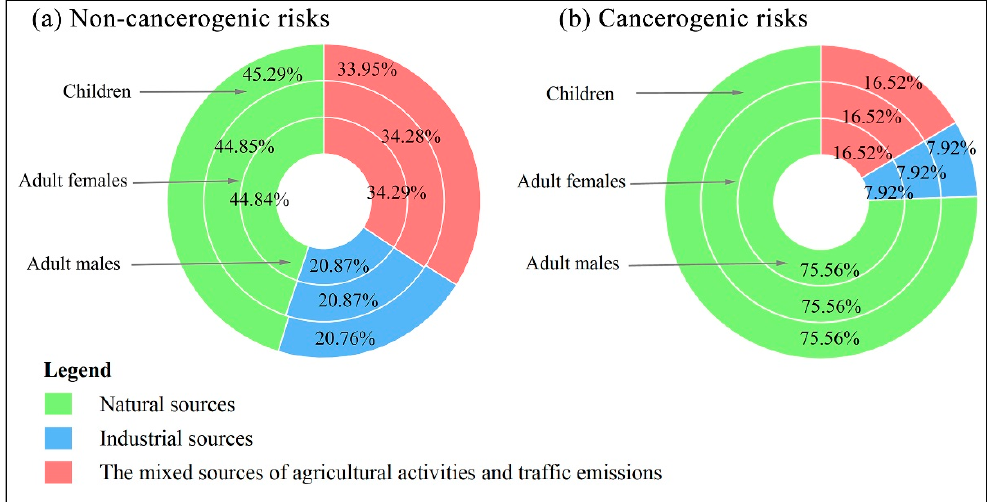
Figure 6. The contribution percentage of each pollution source to ( a ) the non-carcinogenic risk and ( b ) carcinogenic risk by heavy metals in groundwater for adult males, adult females, and children, respectively.